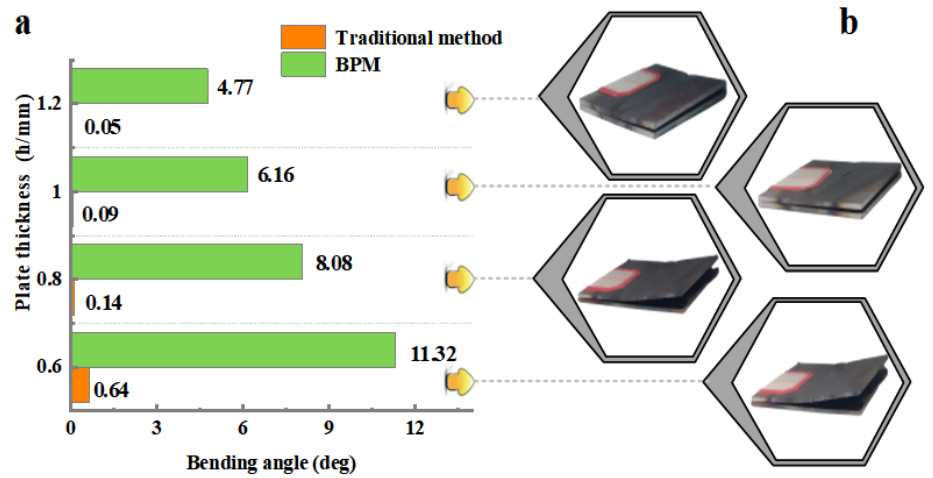
Figure 11. Comparison of the bending angle between the two methods under different plate thick- nesses: ( a ) the bending angle and ( b ) the actual plate.